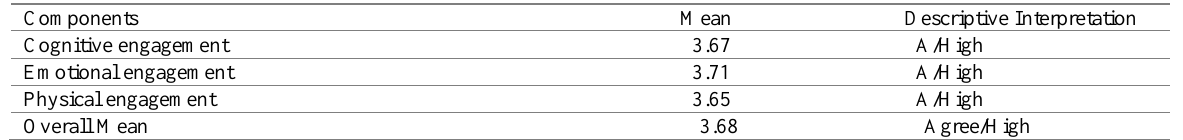
Table 11: Work Engagement Summary Table